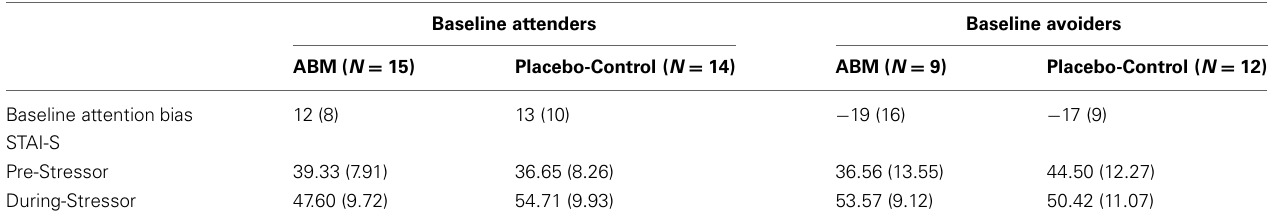
Table 2 | Means and SDs of baseline attention bias and state anxiety (STAI-S) pre- and during-stressor, for baseline attenders and avoiders by training